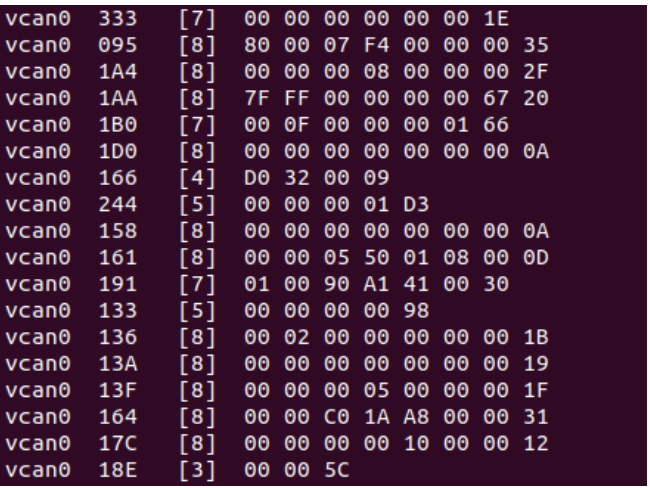
Figure 5. The CAN messages generated by ICSim that are sent on the vcan0.